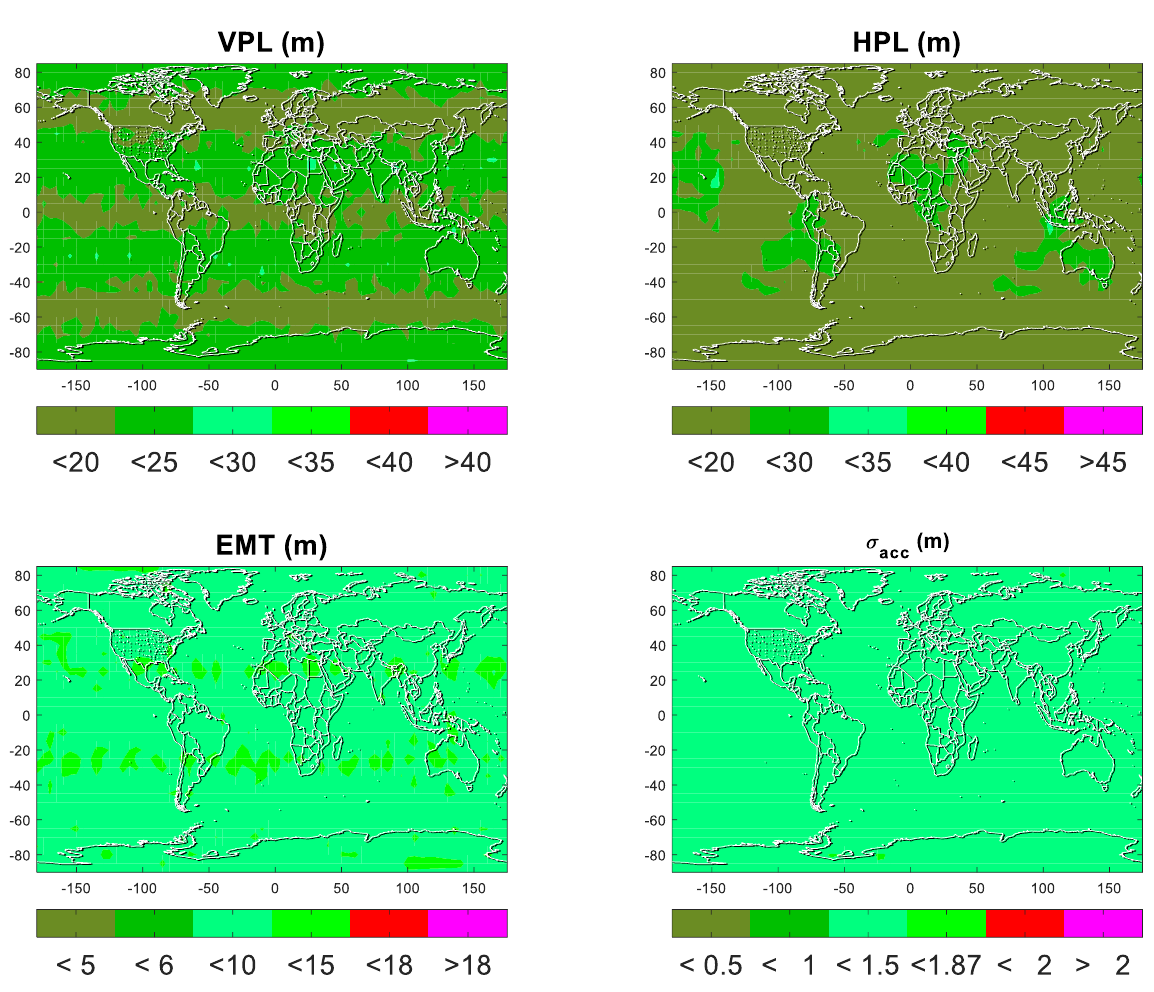
Figure 5. Performance of ARAIM with constellation dynamic selection. From top to bottom, from left to right is VPL, HPL, EMT, and σ acc , respectively.